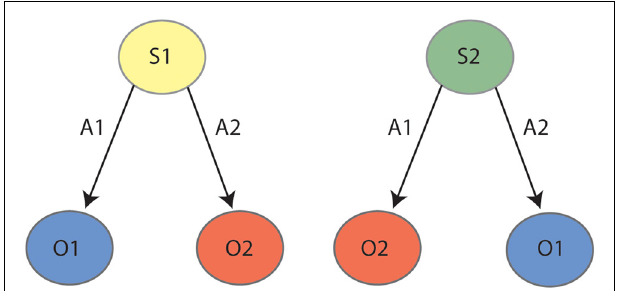
FIGURE 1 | State-space representation for contingency degradation: during the initial phase (left panel) the animal learns that action 1 (A1) earns outcome 1 (O1) and action 2 (A2) earns outcome 2 (O2). During degradation (right panel), the animal learns that in addition to A1–O1 and A2–O2, taking any “other action” (OA, anything other than pressing the levers, e.g., sitting, sniffing, exploring, et cetera) also earns O1, which serves to degrade the